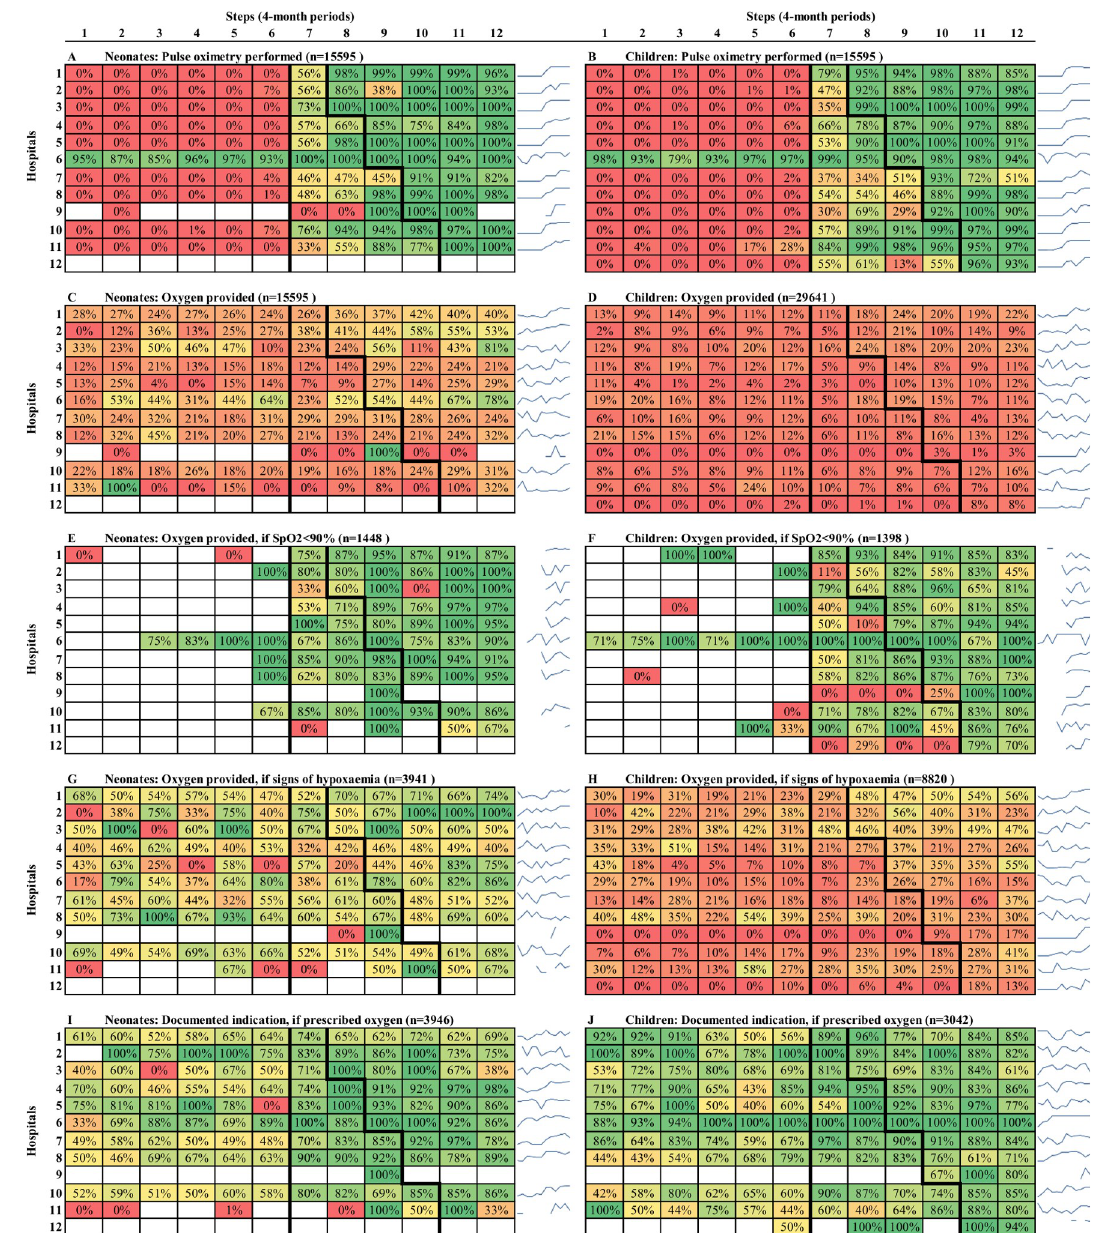
Fig 2. Care practice outcome rates (proportions), by step and hospital. Each cell contains the proportion of patients who received a particular element of care (pulse oximetry or oxygen therapy) on admission. For each of the 10 panels in this figure, the 12 hospitals are represented on the y-axis, whereas the steps of the trial are represented on the x-axis. The colour gradient extends from red (0%) through yellow to green (100%), providing a visual representation of practice change over time. Blue spark-lines show the hospital- specific trend for easy reference. When the denominator to compute the cell rate is 0, cells are coloured in white. Notes: Data from November/December 2013 not available in step